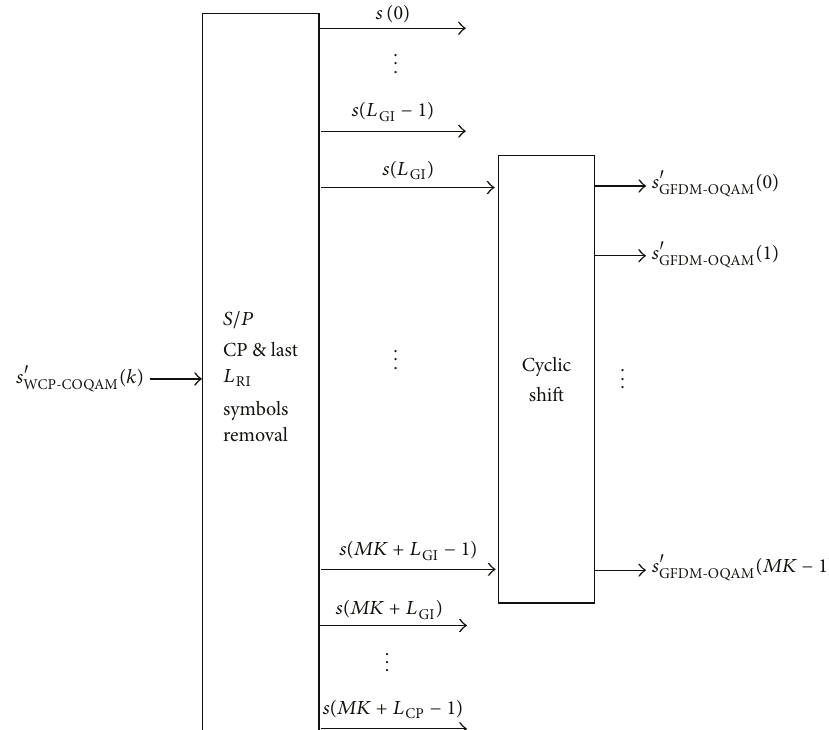
Figure 7: Block diagram of one GFDM-OQAM block recovery process from a WCP-COQAM